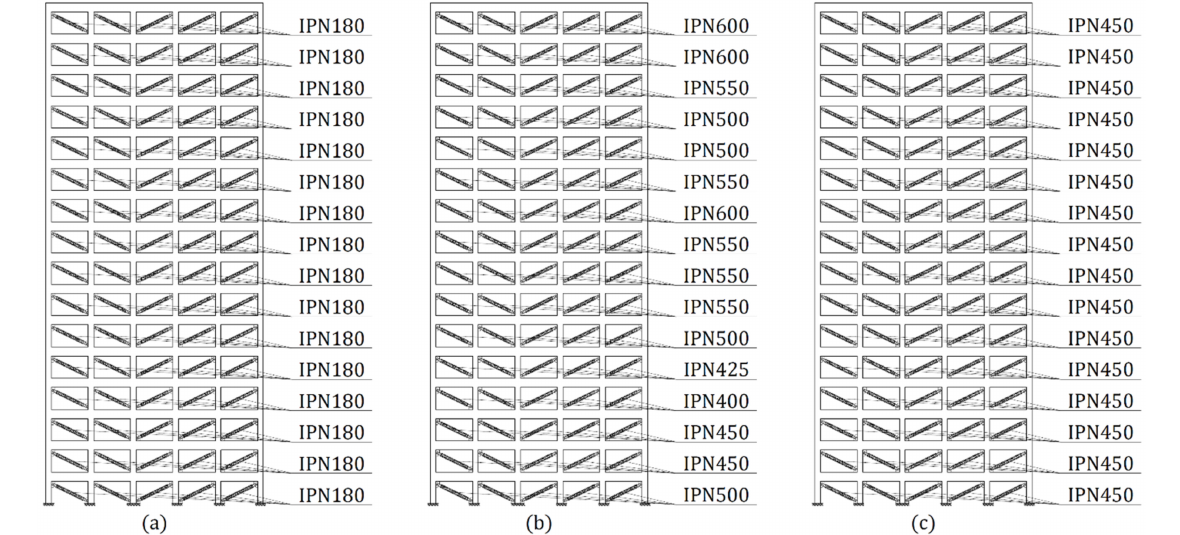
Figure 12. Fifteen-story rigid frame system configurations: ( a ) initial BRBs allocation ( b ) optimal BRBs allocation ( c ) equivalent uniform BRBs distribution.